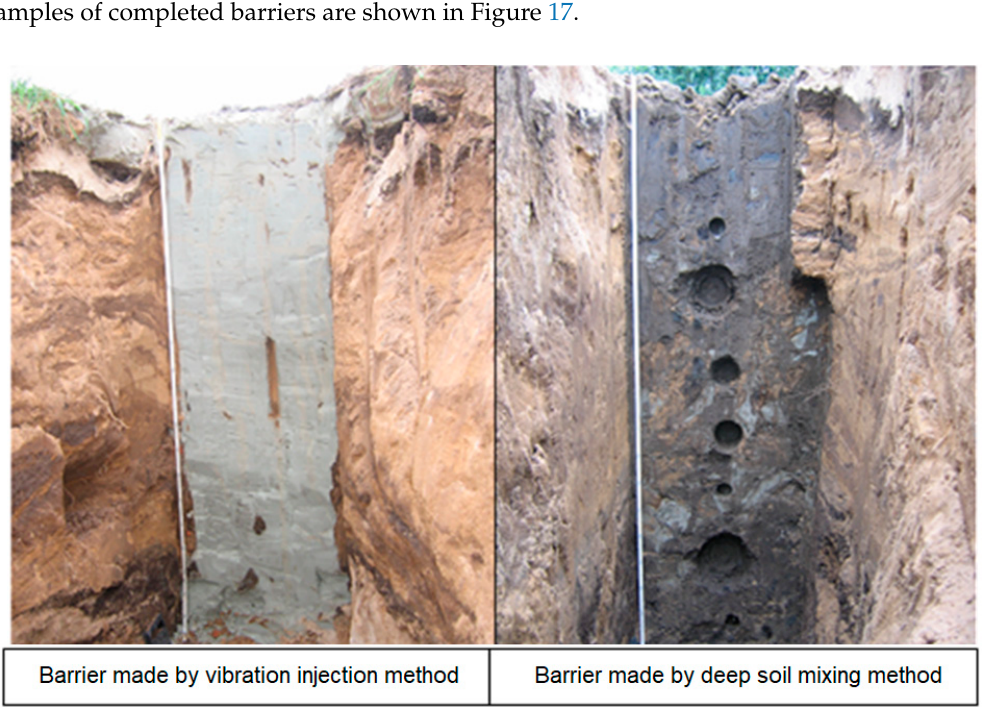
Figure 17. Excavations with visible waterproofing screens (by Ł ukasz